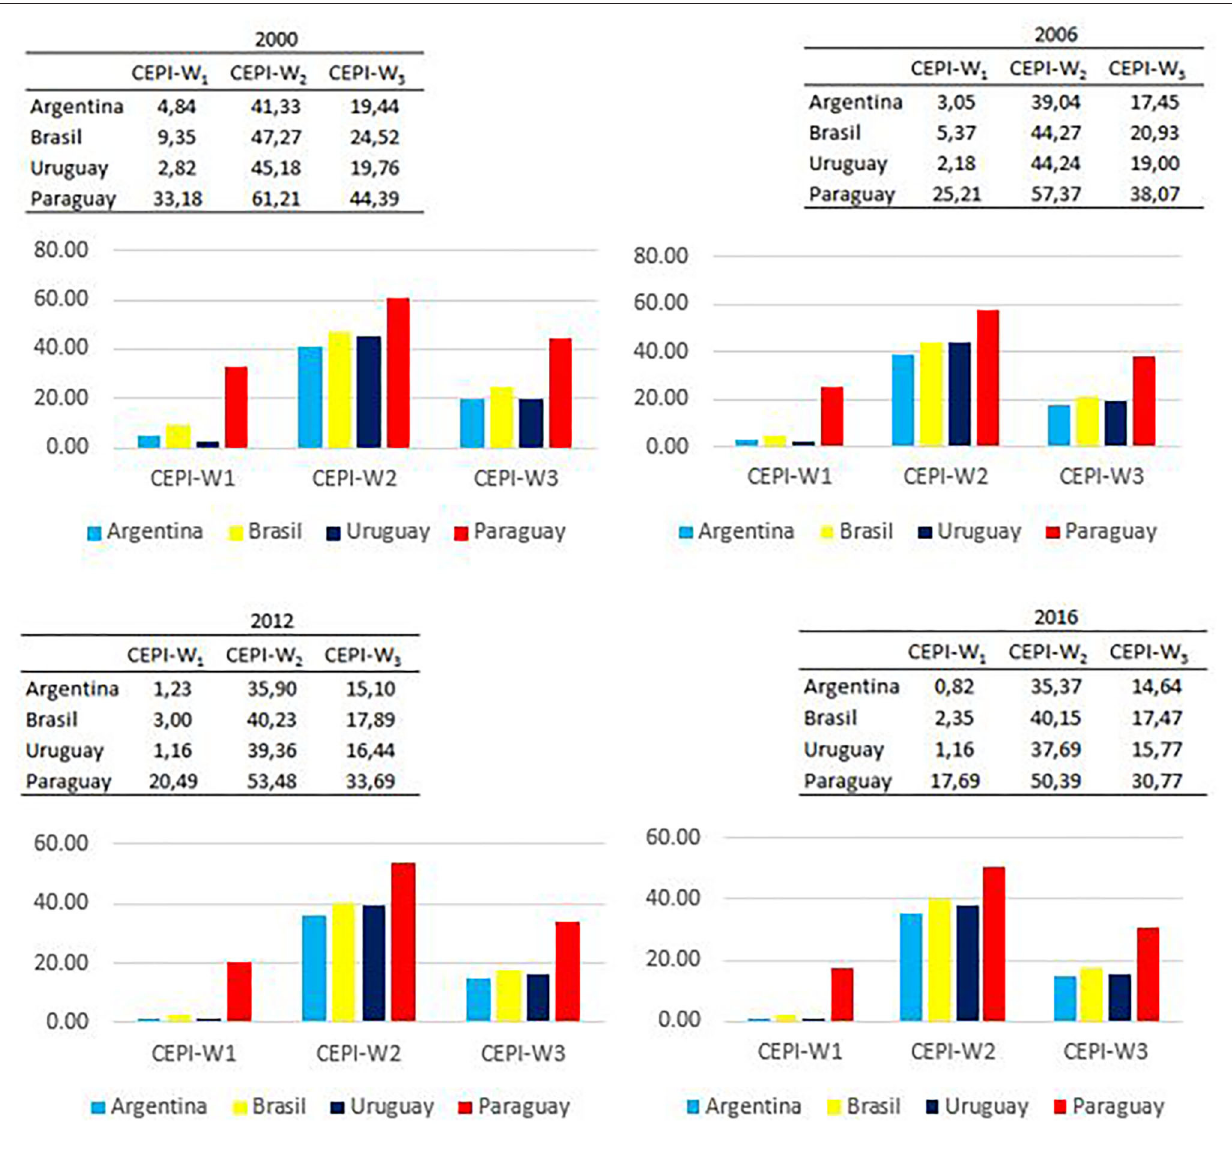
FIGURE 2 | CEPI (2000, 2006, 2012, 2016)—Scenarios W1, W2 and W3.